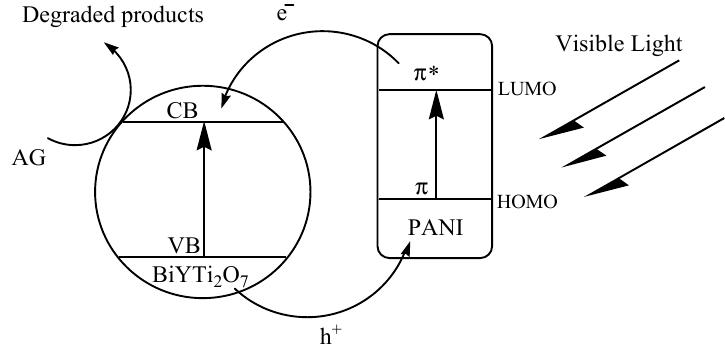
Figure 17. Schematic representation of the mechanism of photocatalytic degradation with PANI-modified BiYTi 2 O 7 .